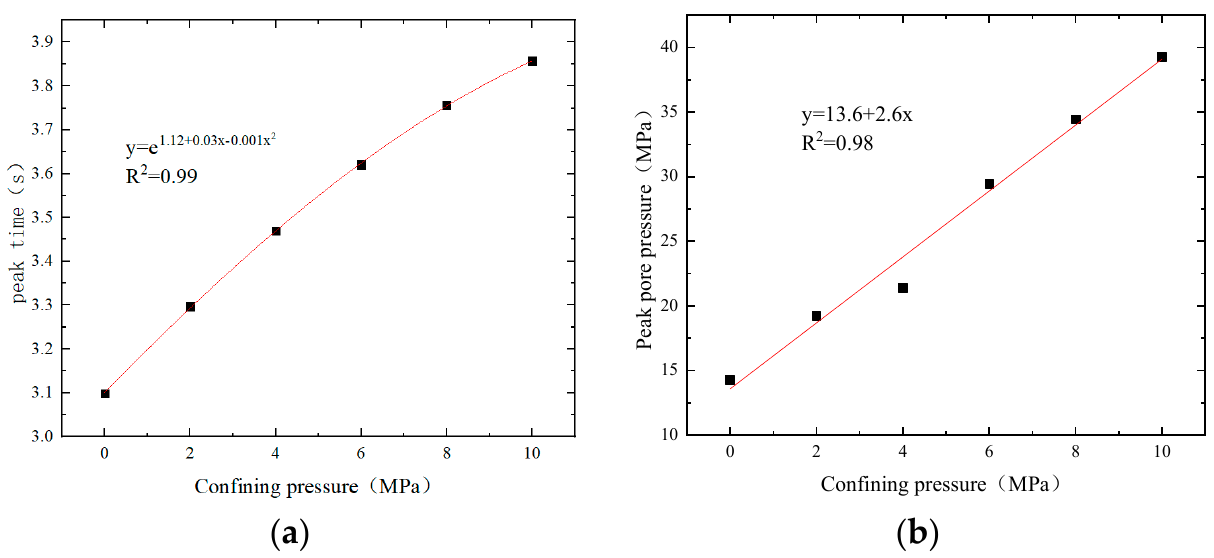
Figure 7. The influence of different confining pressures on fracture development. ( a ) Confining pressure-peak time; ( b ) Confining pressure-peak pore pressure.